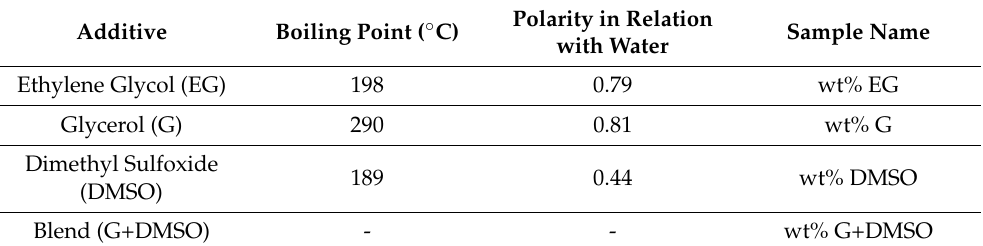
Table 1. Additives, additive boiling point, polarity, and sample name, where wt.% is the weight per cent between the water of the pristine PEDOT:PSS dispersion and the additive. Additive Boiling Point ( ◦ C)